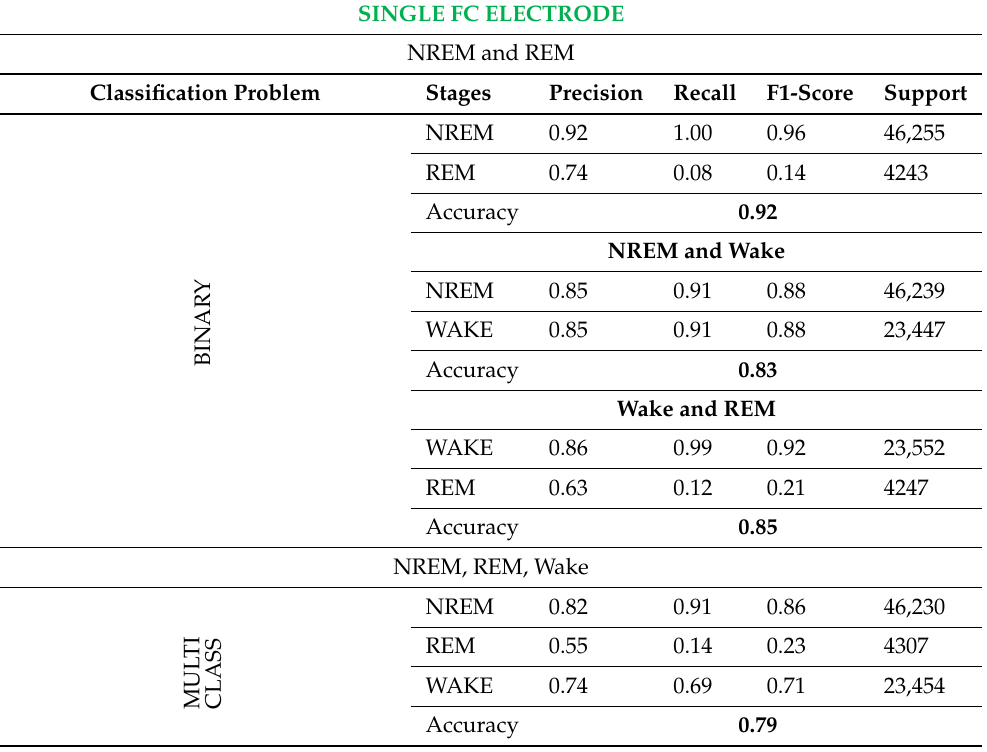
Table 4. Performance measures for binary and multiclass